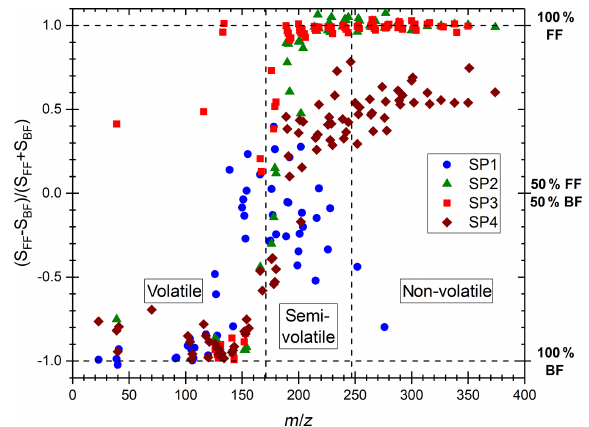
Figure 3. “Contrast plot” representing the variation in PAH sig- nal detected with L2MS at λ i = 266nm for the four miniCAST set points. Values on the y axis correspond to the partitioning of the species between the front filters and back filters: − 1 indicates that the species are all found on the BF, + 1 that they are all found on the FF, and 0 that they are equally partitioned on both